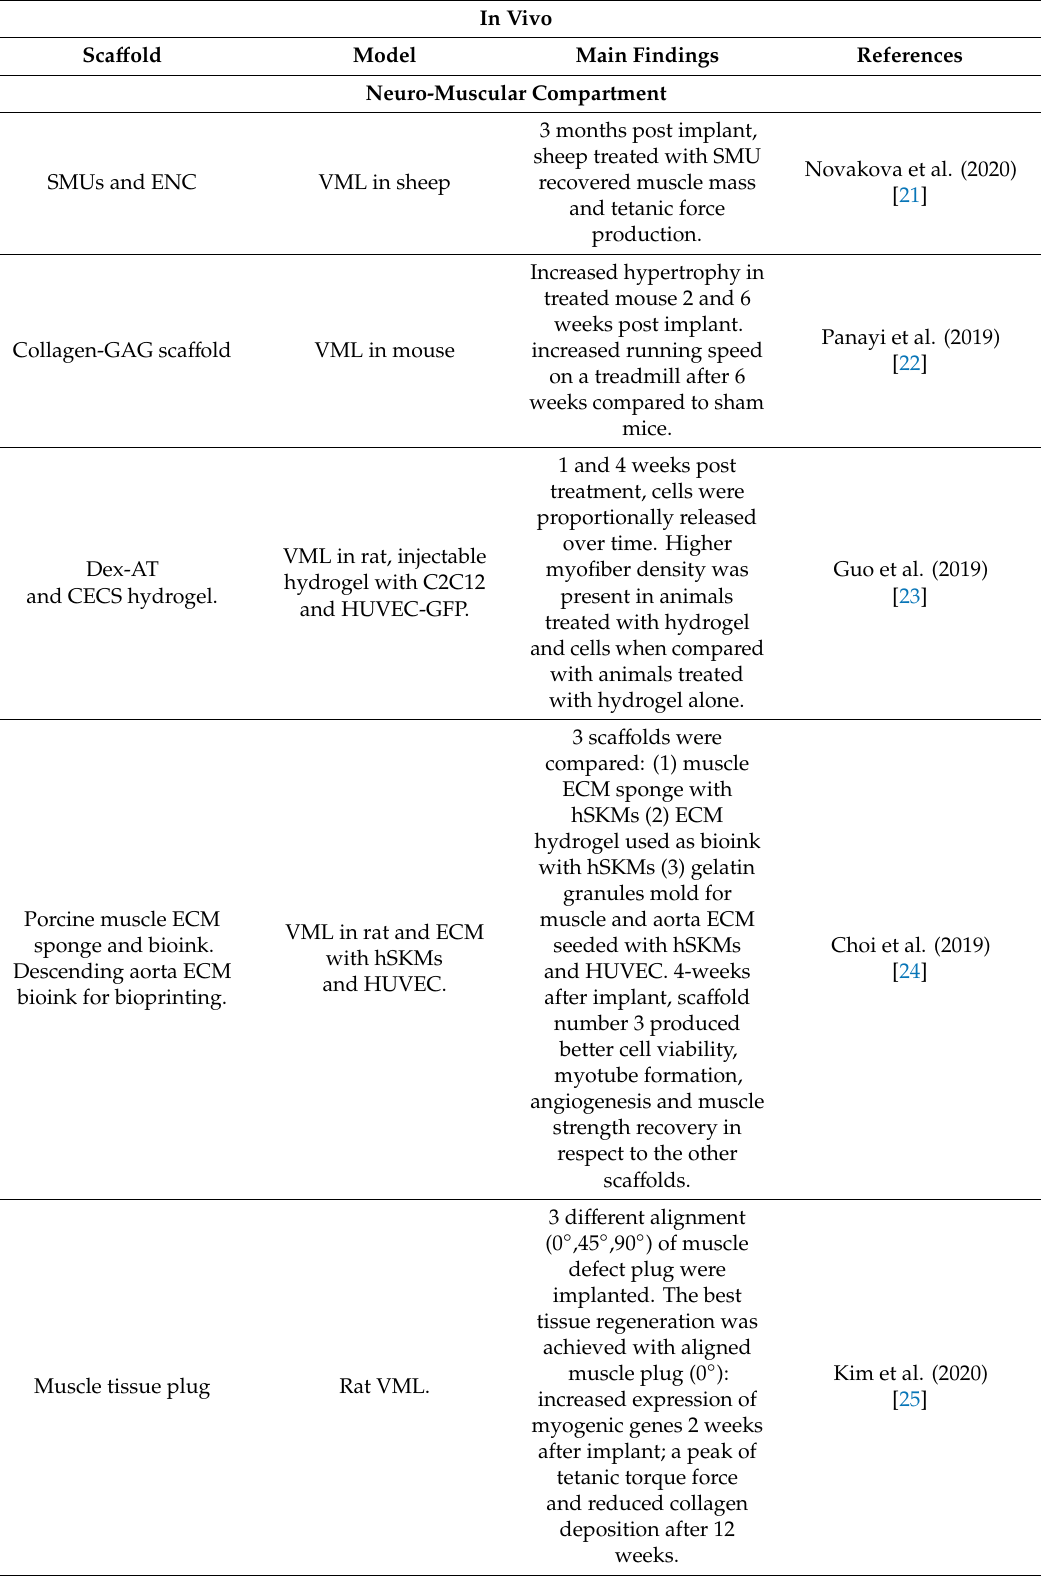
Table 2. In vivo tissue engineering